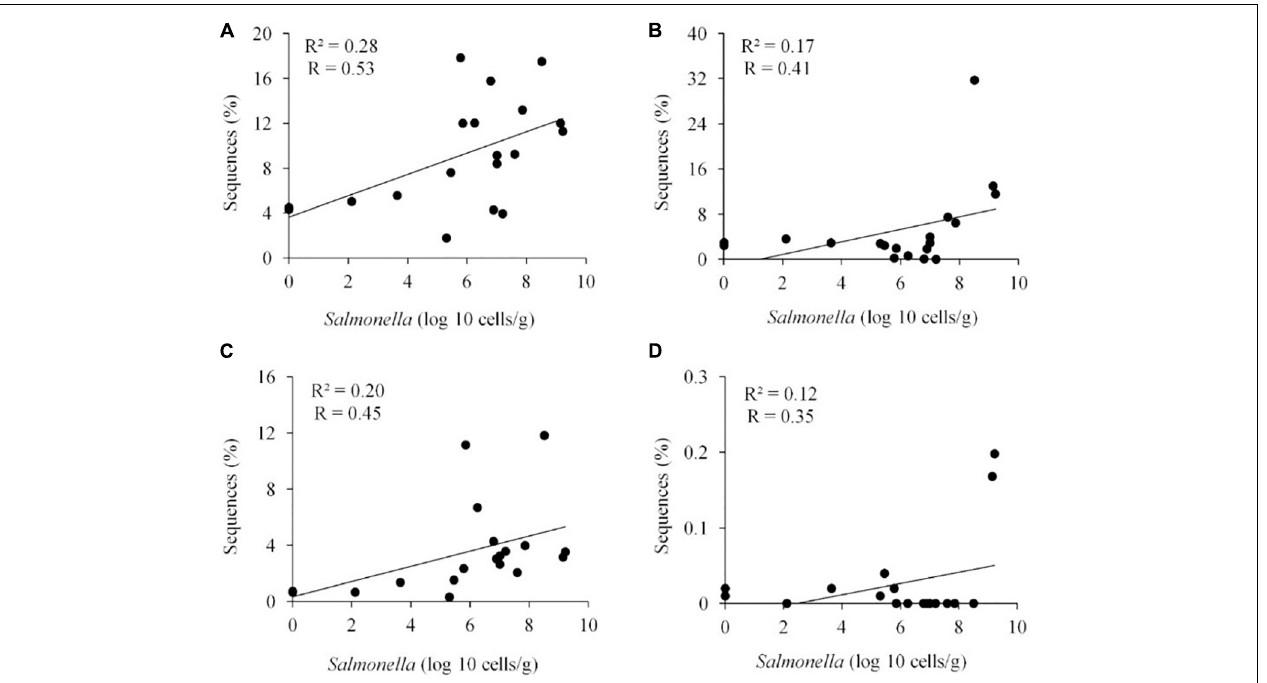
FIGURE 6 | Positive correlation between the presence of specific OTUs and Salmonella abundance in the ceca ( n = 19). Roseburia hominis OTU 3, 97% of similarity to RDP, P < 0.01 (A) ; Robinsoniella peoriensis OTU 4, 98%, NS (B) ; Roseburia hominis OTU 6, 97%, P < 0.05 (C) ; and Eubacterium biforme OTU 79, 93%, NS (D) . R , Pearson correlation coefficient; and R 2 , coefficient of determination.